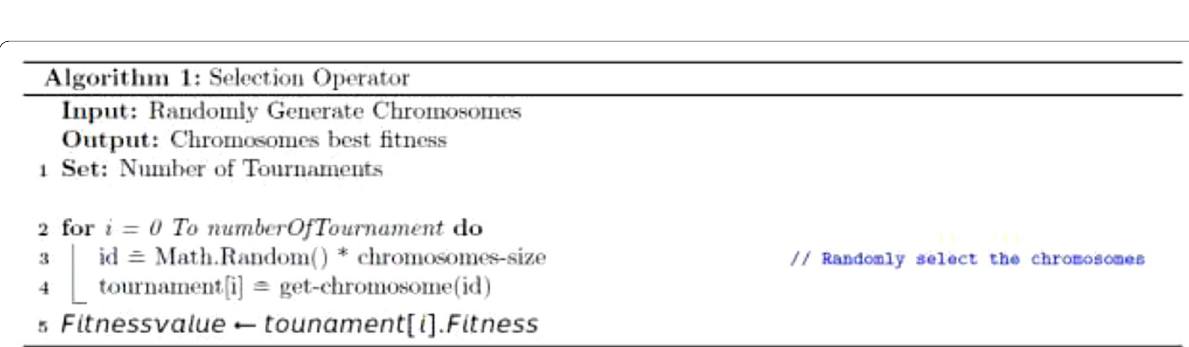
Fig. 3 Selection Operator for the GA part of the eh-GA-PSO